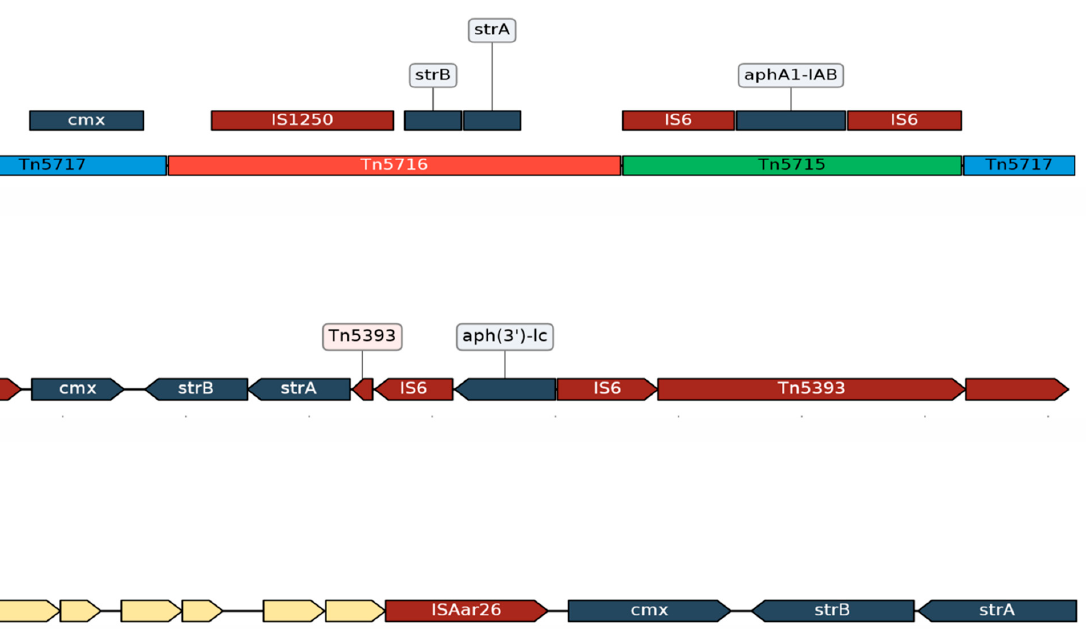
Figure 3. Genomic context of cmx , strA and strB genes. Antibiotic resistance genes are represented in dark blue, the mobile elements in dark red and the hypothetical proteins in the empty boxes. ( A ) Segment belonging to the pTP10 plasmid of C. striatum was documented by Tauch et al., 2000. The segment contains the transposons Tn5717 (transporting the cmx gene), Tn5716 (transporting the strB-strA genes) and Tn5715 (transporting the aphA1-IAB gene). ( B ) Segment belonging to the isolates from Boston, USA [16]. The region shows the cmx , strB-strA genes near a composite transposon (transporting the aph(3 ′ )-lc gene) flanked by two IS26 similar to Tn5715; in addition, the absence of the IS1250 element can be observed. Similarly, the isolates from Beijing, China [33] ( C ) showed the cmx and strB-strA genes are close and without the IS1250 element, in the same sense as the isolates from the USA. The representation of the sequences was done with the DNA Features Viewer tool [68], considering the accession numbers AF024666.2 ( A ), GCA_002803965.1 ( B ), GCA_015946165.1 ( C ).